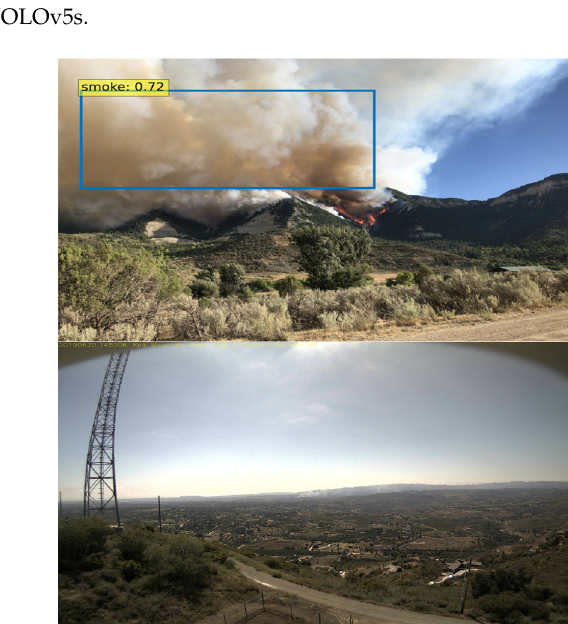
Figure 9. Detection results using DETR.